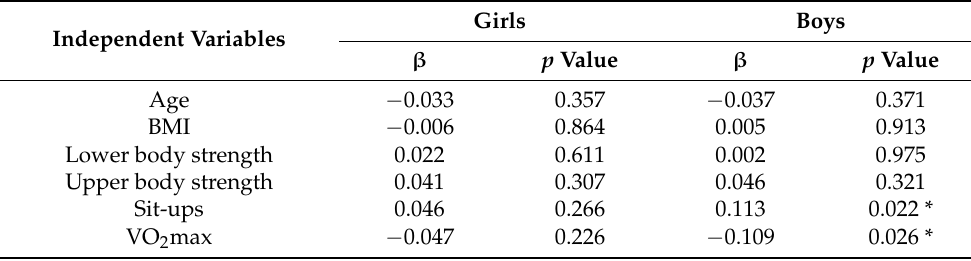
Table 3. Factors associated with sense of coherence, separately for girls (n = 797) and boys (n = 587) (multiple linear regression